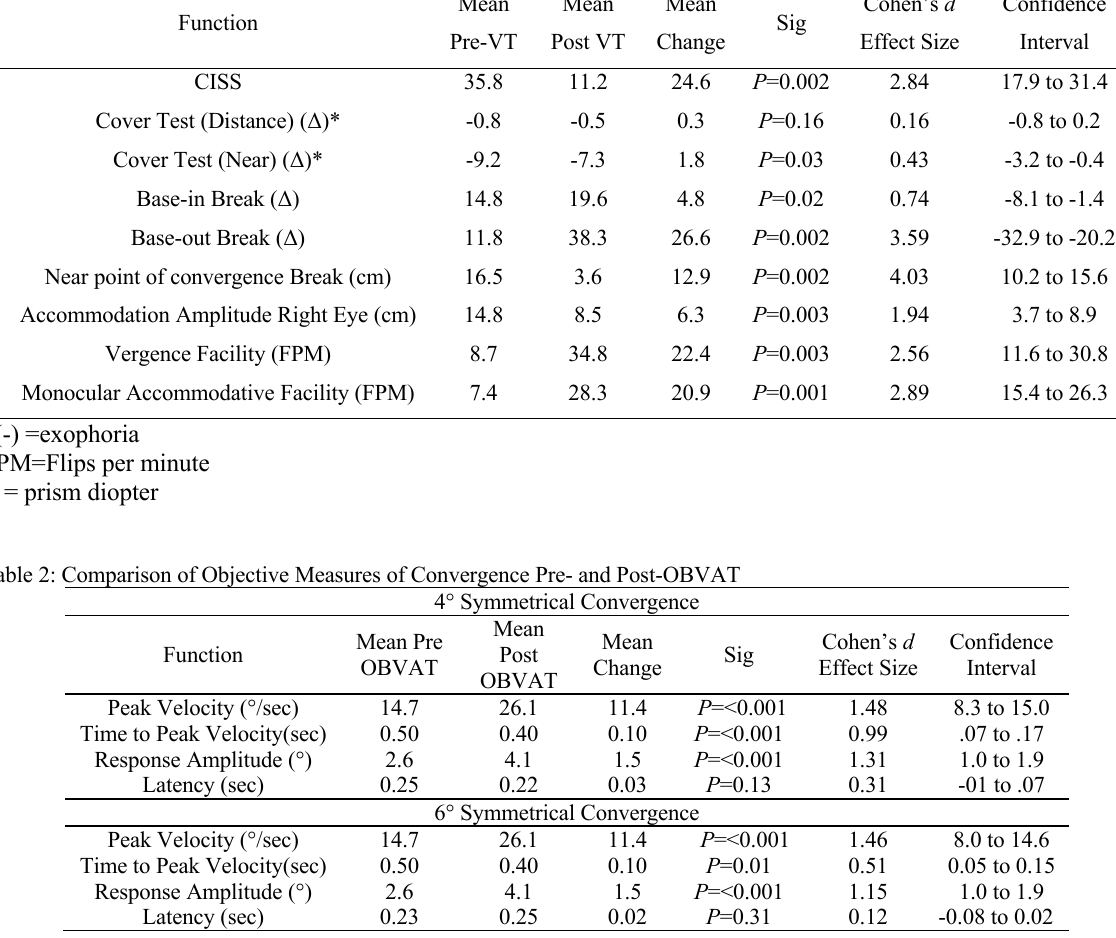
Table 1: Comparison of Clinical Measures of Convergence Insufficiency Participants Pre-and Post-OBVAT Function